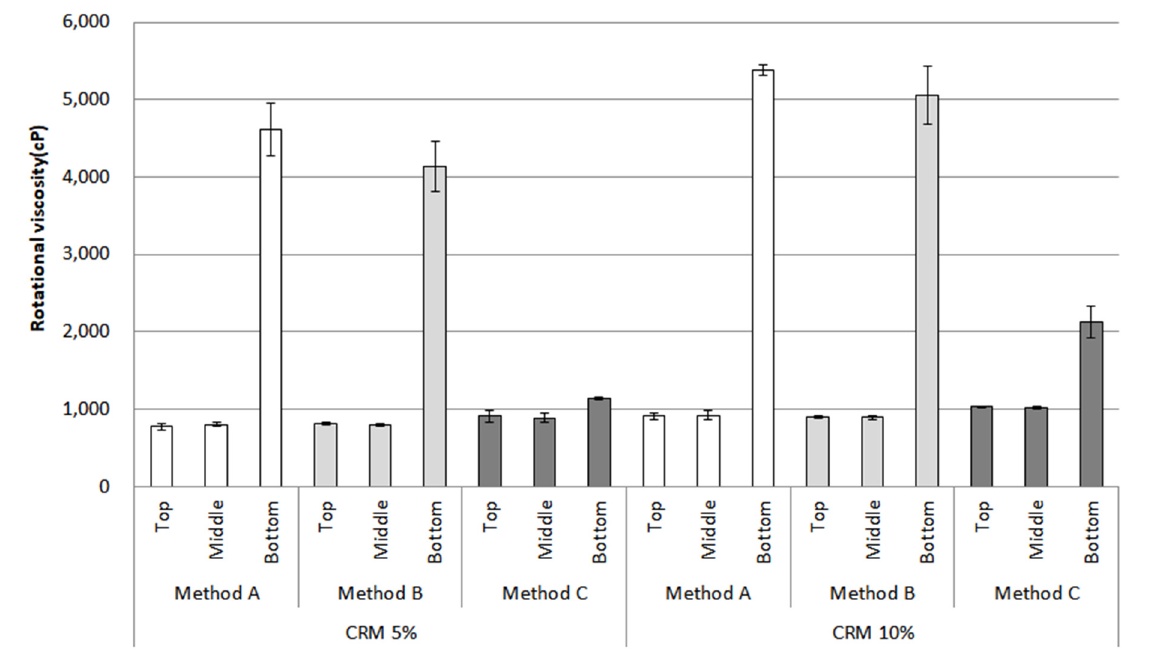
Figure 8. Rotational viscosity (135 °C) of the CRM asphalt binders in each mixing method for the top, middle, and bottom parts after conditioning.